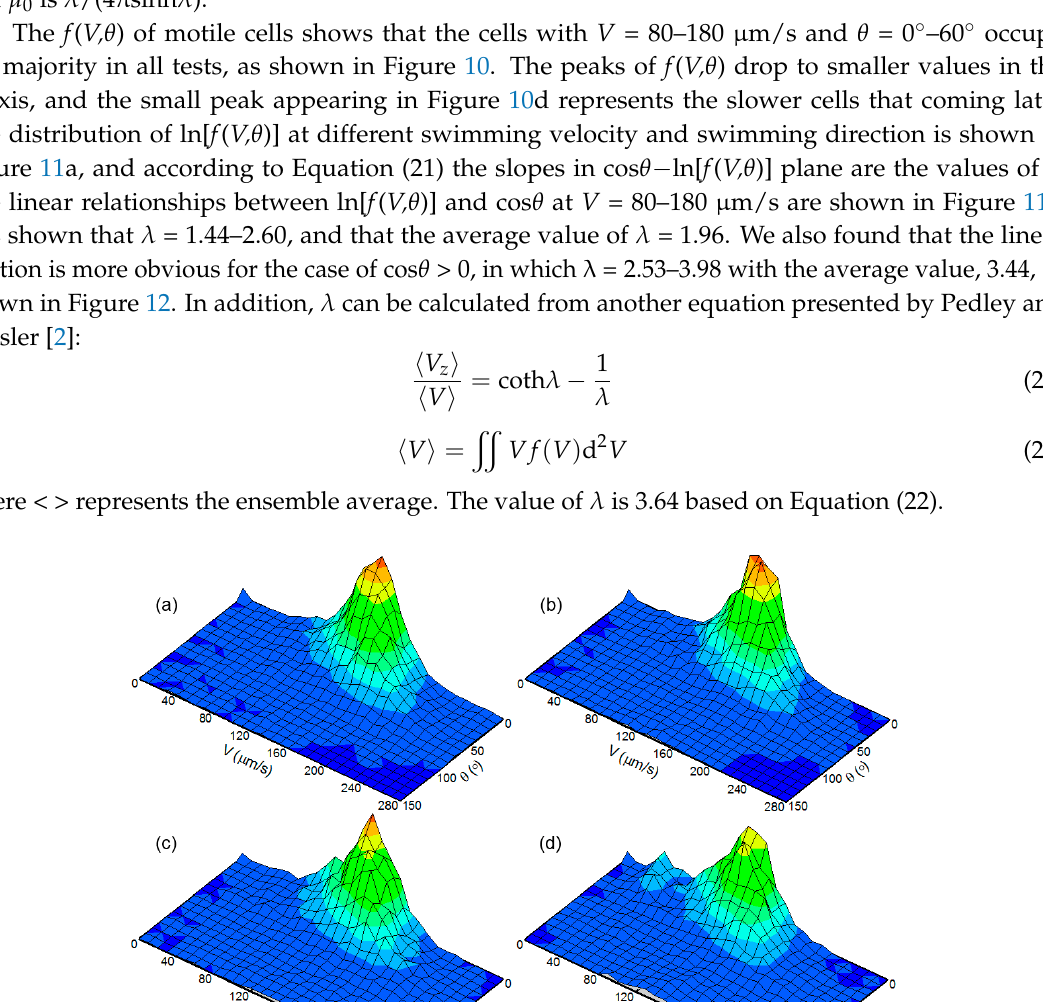
Figure 11. Distribution of ln[ f ( V, θ )]: ( a ) ln[ f ( V, θ )] versus V and cos θ , ( b ) ln[ f ( V, θ )] versus cos θ for given V . Figure 12. λ at different values of V with the red bars corresponding to the values of all cells in tests and the black bars corresponding to the values of cells that only walk upwards.